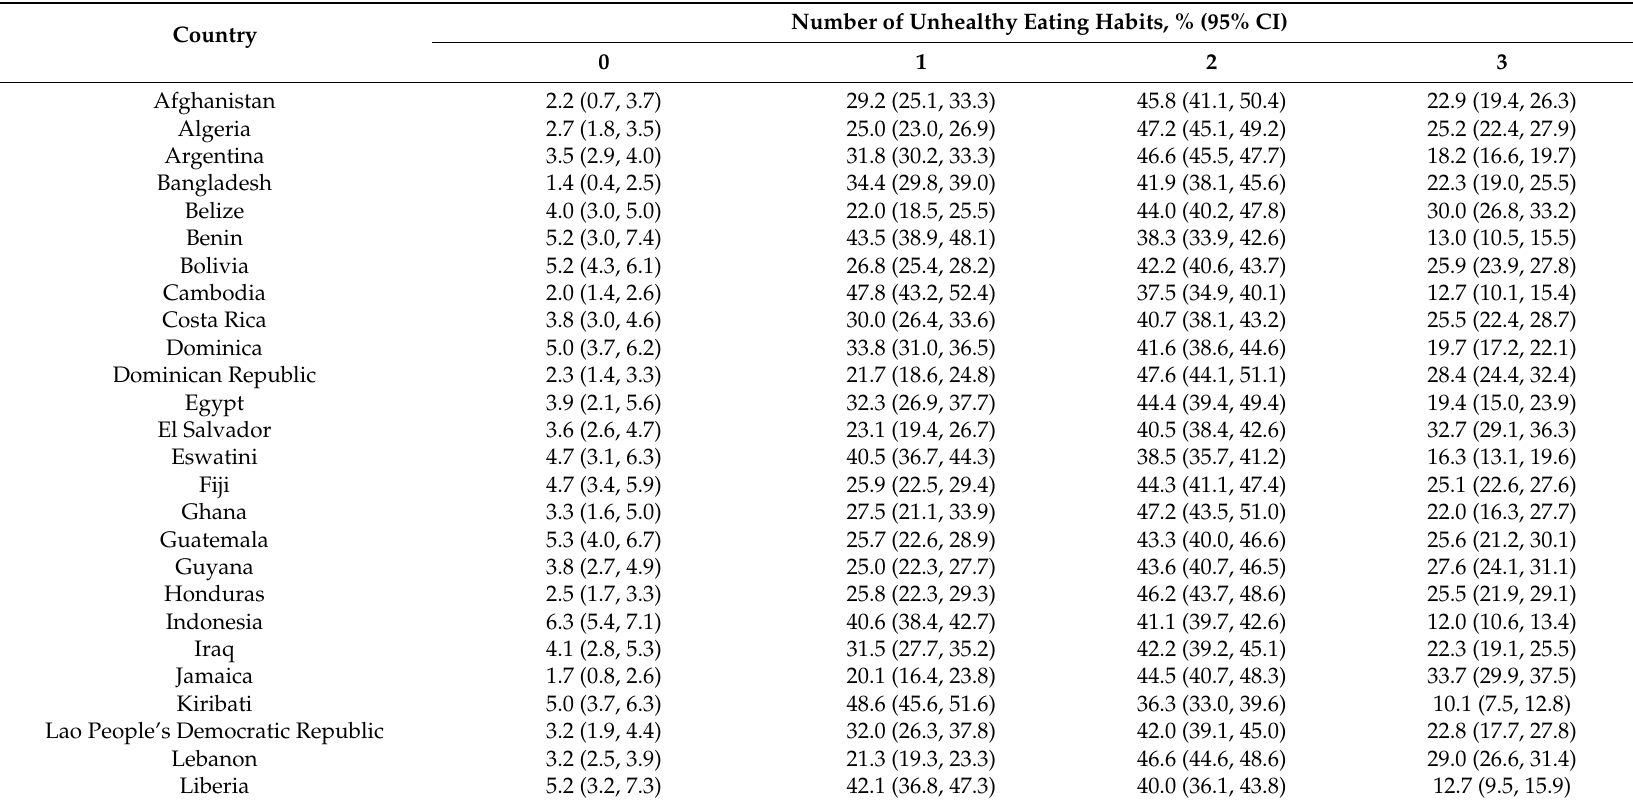
Table 3. Clustering of unhealthy eating habits across